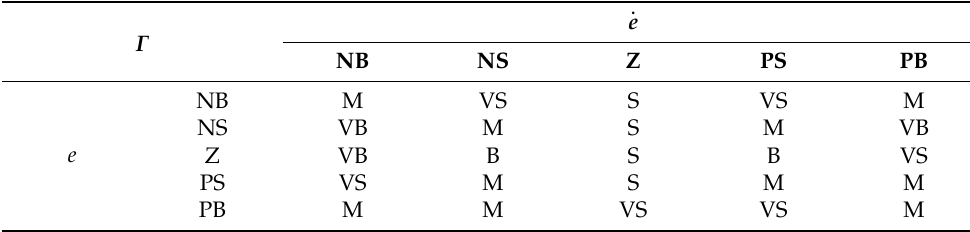
Table 1. Fuzzy tuned rules for Γ .